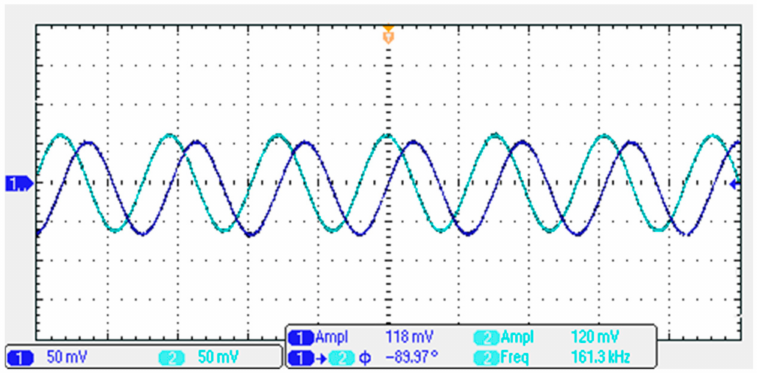
Figure 41. The measured waveforms of the quadrature voltage outputs V o4 and V o5 in the time domain.